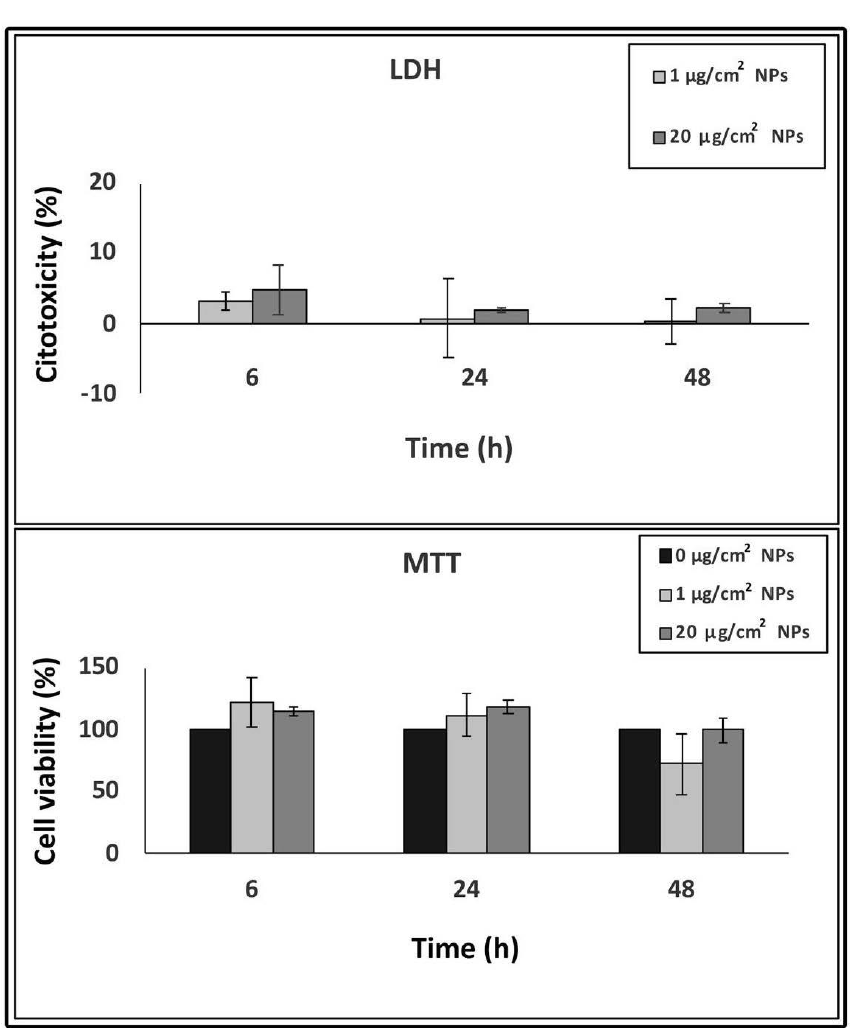
Figure 2. Concentration and time-dependent cytotoxicity of TiO 2 NPs in HT-29 cells measured by lactate dehydrogenase (LDH) and 3-(4,5-dimethylthiazol-2-yl)-2, 5-diphenyltetrazolium bromide (MTT) assays. Data are presented as % of the control (taken as 0% cytotoxicity for LDH and 100% cell viability for MTT) with means ± SD calculated from three independent experiments.